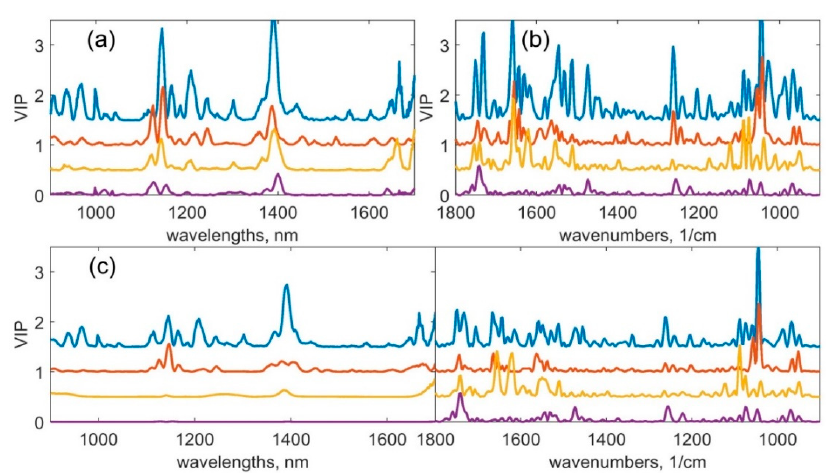
Figure 4. Variable importance in Projection (VIP) for models from Table 2. ( a ) Models #1, 4, 7, 10 (models built using NIR data); ( b ) models #2, 5, 8, 11 (models built using MIR data); ( c ) models #3, 6, 9, 12 (models built using concatenated data). Each curve was shifted up by 30% from the previous curve on the y -axis for better visualization of the VIP values. Models built using full datasets (colon, stomach, rectum: CSR) are shown in blue, red—colon datasets, yellow—stomach datasets and violet—rectum datasets.